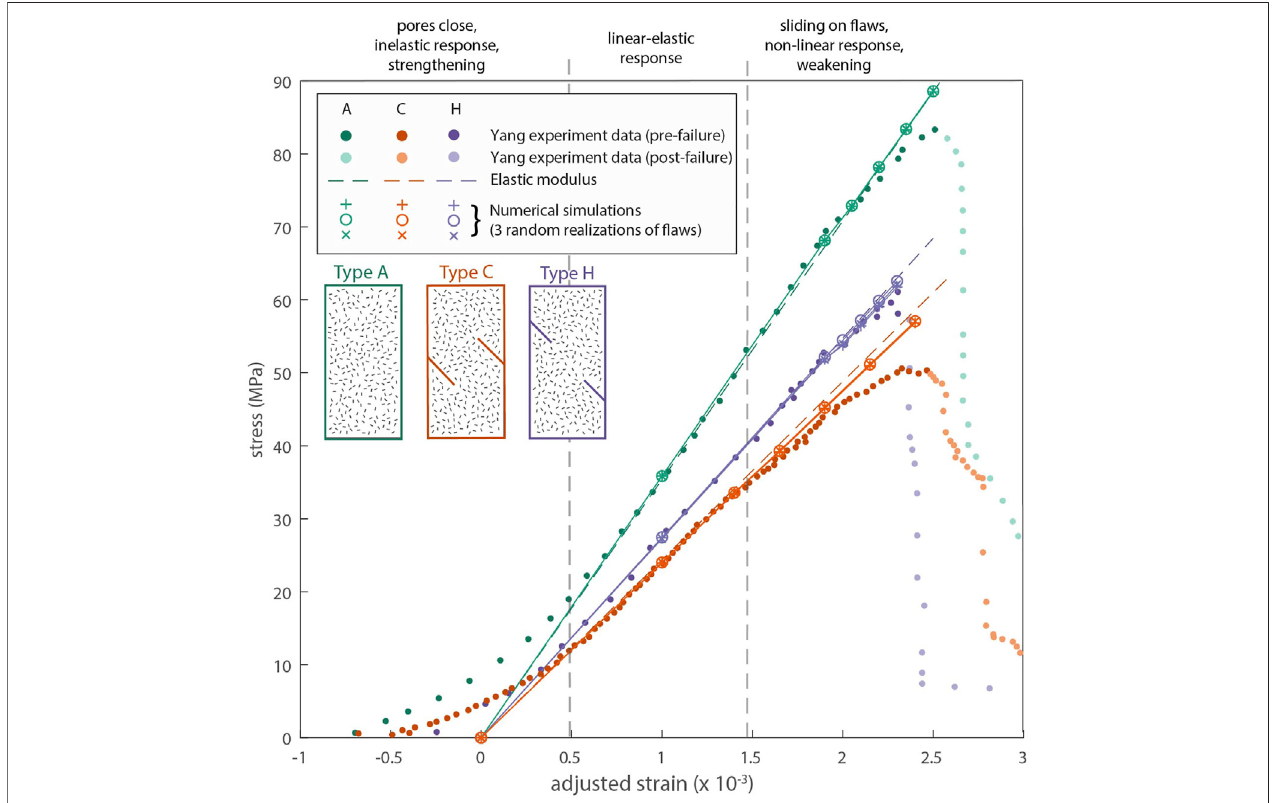
FIGURE 4 | Pre-fracture growth models of stress-strain response for three experimental setups. Data from Yang et al. (2009) experiments is shown as solid dots (darkcolorsprecedingfailure,lightercolorsafterfailure).Resultsareshownfromthreesimulationsofexperimentsetup(A,C,andH)thatincludedifferentsetsofrandomly distributed microcracks that slide, open, and interpenetrate. These simulations do not include fracture growth, so as to isolate and highlight the impact of microcrack deformation alone. The strain values of the experiments were shifted to remove the nonlinear stress-strain response at the beginning of experiments when pore space closes, which is not captured in the model. Dashed lines show the effective elastic modulus for each setup derived from the experiment data. The deviation from the linear stress-strain response near macroscopic failure results from sliding and opening on microcracks at higher strain levels. This deviation is more prominent in simulations with pre-cut